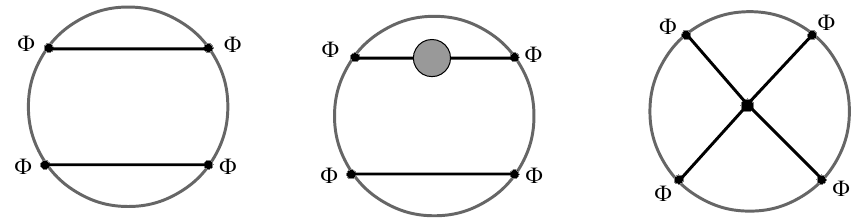
Figure 4 . Witten diagrams in AdS 2 contributing to the 4-point function of single-letter insertions (cid:8) to next-to-leading order at strong coupling. The grey blob in the middle (cid:12)gure denote the one-loop correction to the \boundary-to-boundary" y